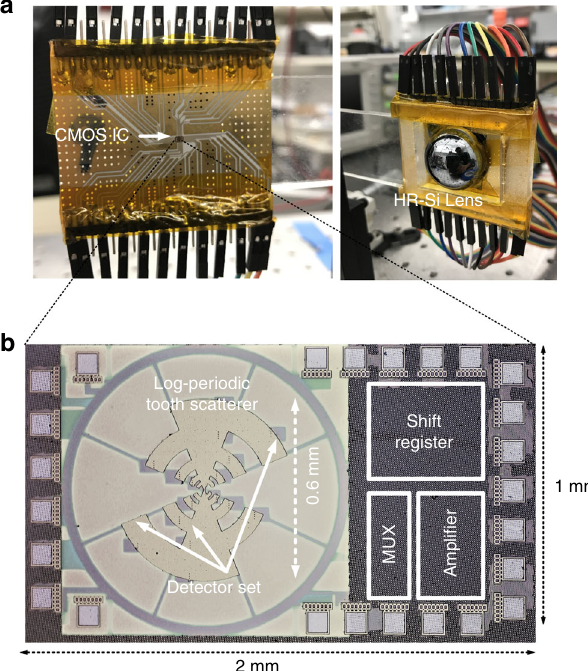
Fig. 6 The chip photo and the packaged system. a The chip is packaged on a printed circuit board supported by a silicon wafer at the back. A high- resistivity silicon lens abuts the back of the silicon wafer to enable reception of the THz waves from the backside. b The chip is implemented in